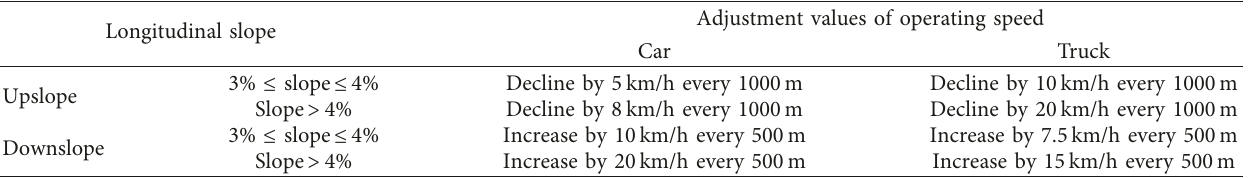
Table 9: Operating speed conversion model for longitudinal slope section.